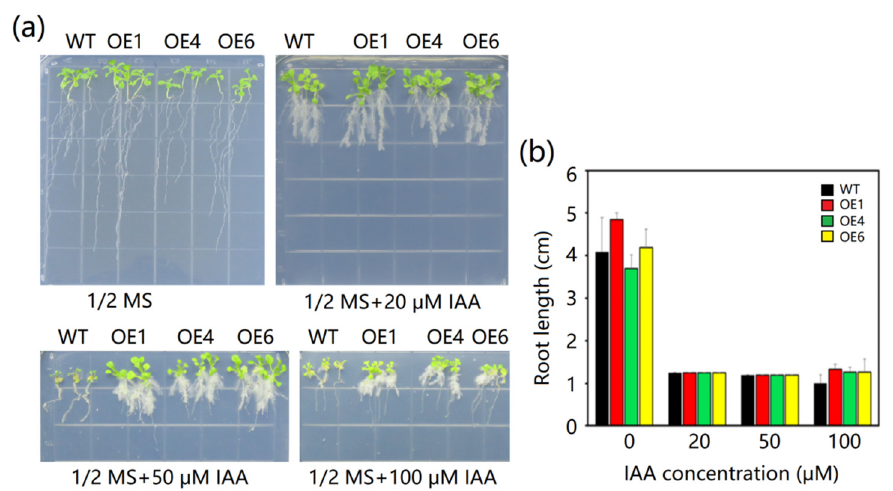
Figure 7. ( a ) Phenotypes and ( b ) root length of transgenic Arabidopsis under IAA stress. Error bars indicate ± SD.